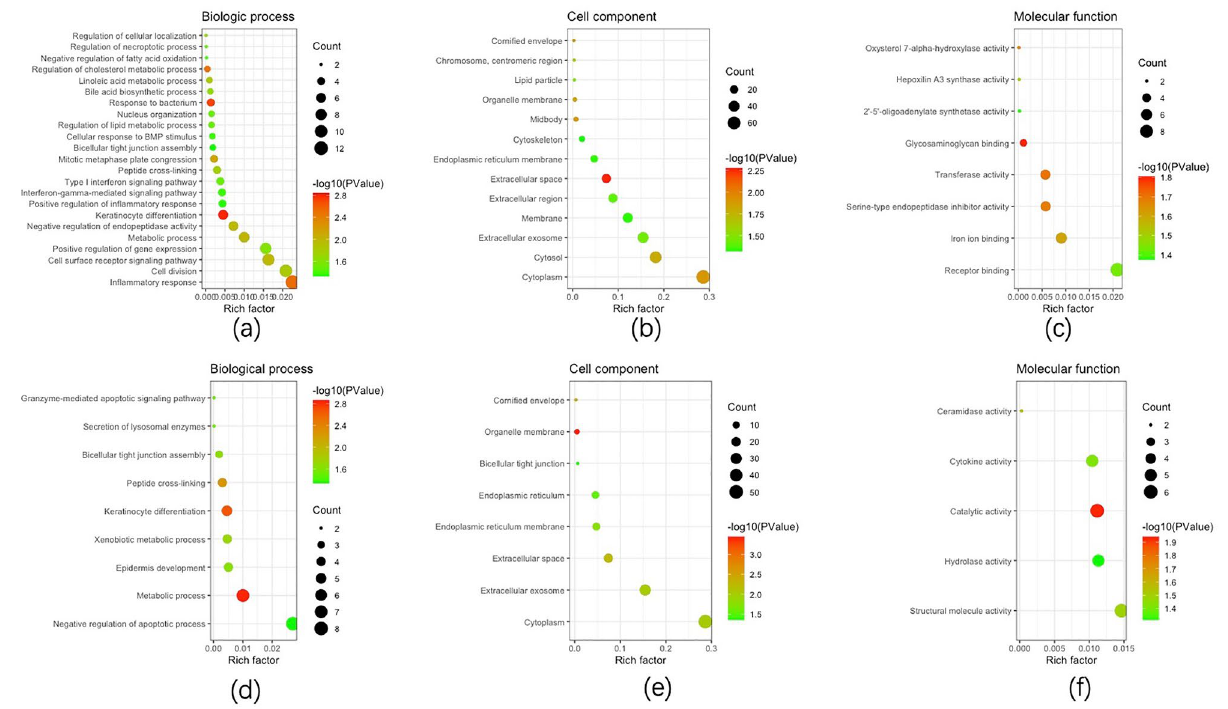
Figure 3. GO analysis of DEGs obtained among the different groups as determined using DAVID. ( a–c ) lesioned skin samples of AD patients versus healthy controls; ( d–f ) non-lesioned skin samples of AD patients versus healthy